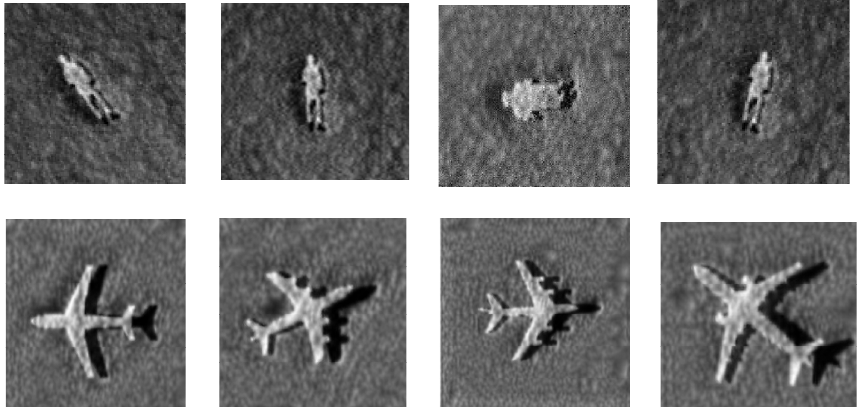
Figure 7. Similar side-scan sonar images: the first row are images of the drowning victim; the second row are images of the airplane.